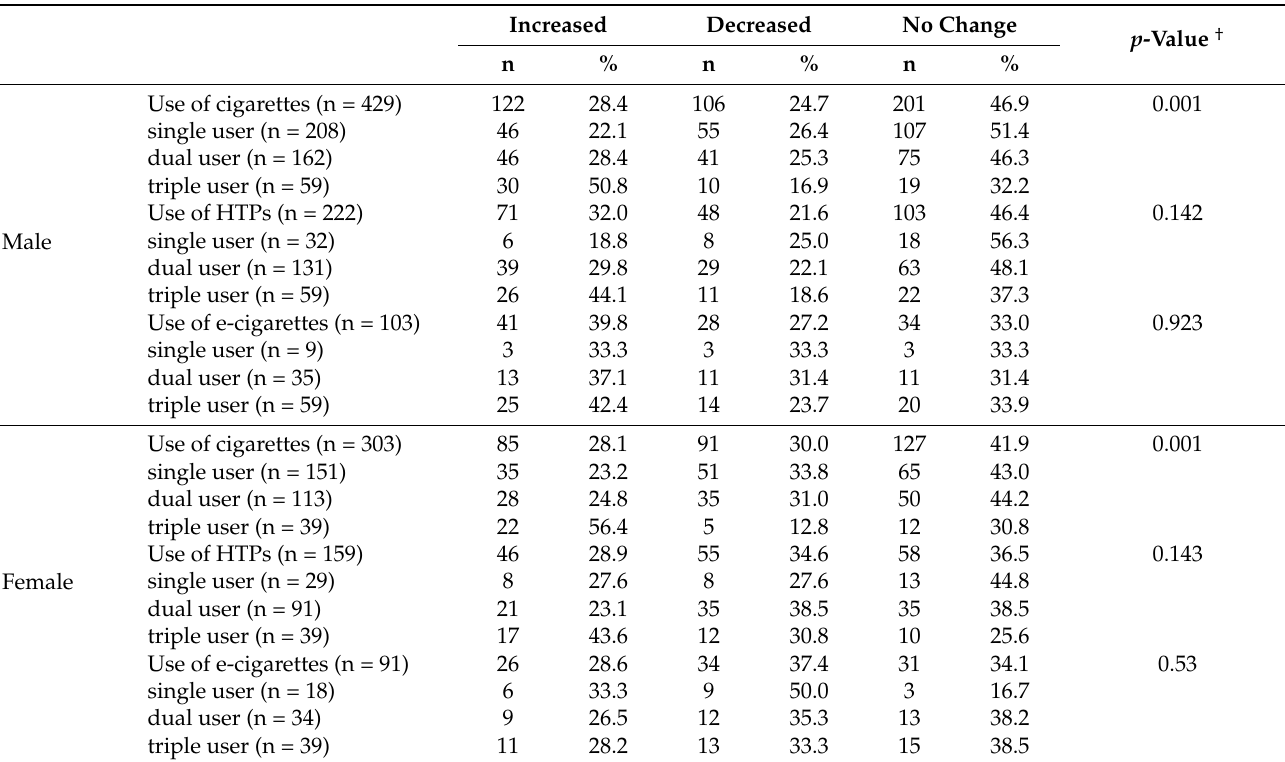
Table 2. Subjective changes in usage stratified by tobacco product over the past